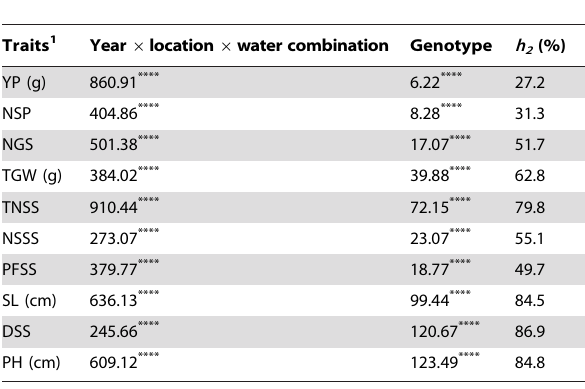
Table 3. F values of ANOVA for genotypes and environments in wheat DH